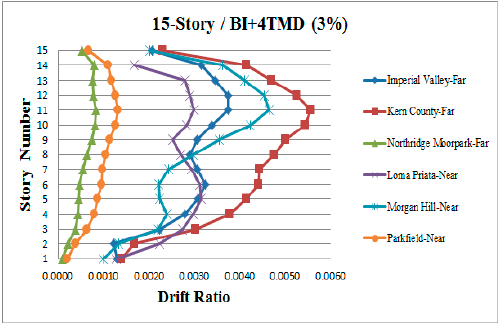
Figure A33. Drift ratios for 15-story base-isolated building with 4 TMDs.